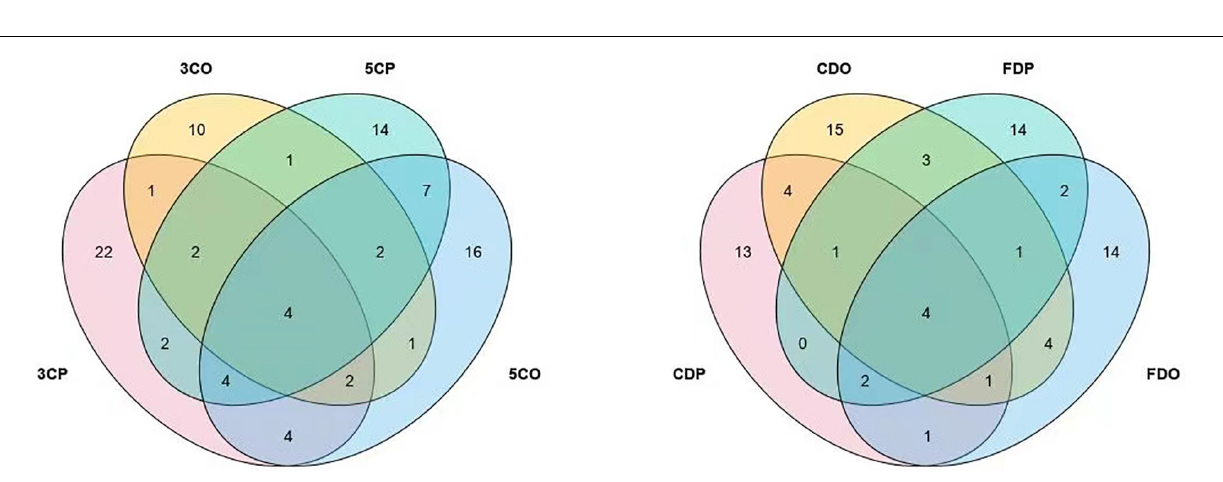
Frontiers in Microbiology |